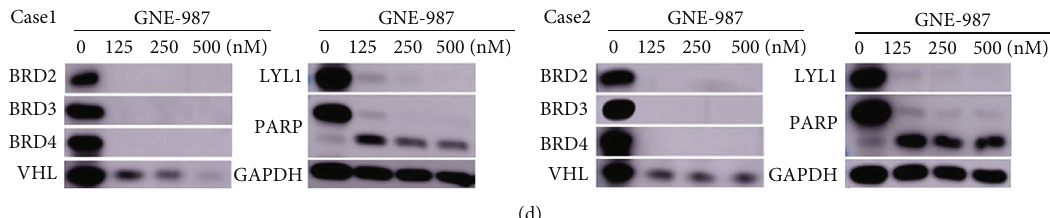
Figure 6: GNE-987 shows cytotoxicity in primary AML cells. (a) Clinical and molecular characteristics of 2 primary pediatric AML. (b) The drug sensitivity of 2 cases of primary cells treated with gradient concentrations of GNE-987, JQ1, and ARV-825 for 24 hours was determined. (c) After 24 hours of treatment with DMSO or di ff erent concentrations of GNE-987, the primary cells were analyzed for Annexin V and PI-labeled apoptosis by fl ow cytometry. The apoptotic rate of primary cells increased signi fi cantly after GNE-987 treatment. (d) The Western blot analysis showed that GNE-987 induced the degradation of BET protein, and VHL and LYL1 proteins were also downregulated, and PARP in these primary AML cells